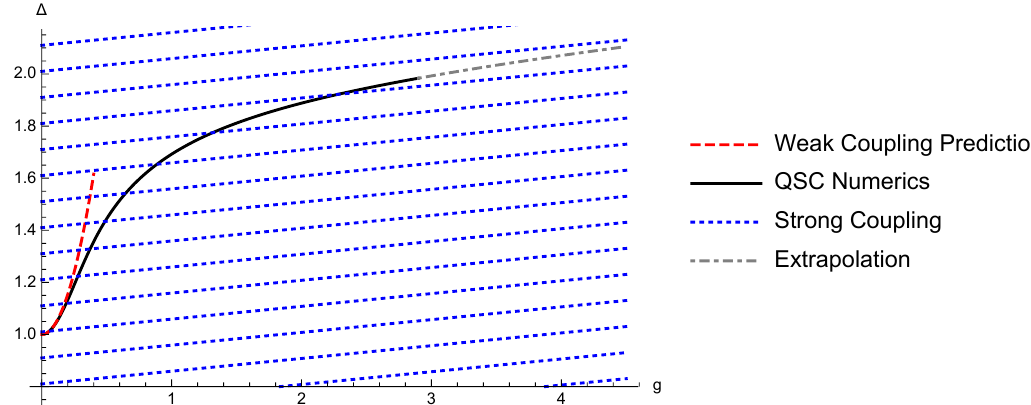
Figure 5 . This plot shows our numerical data for the case (cid:30) = 0 and (cid:18) = (cid:25)= 8. The dashed red line represents the one-loop result at weak coupling, which we conjecture to take the form (cid:1)( g ) = 1 + 4 g 2 cos 2 ( (cid:18)= 2) + O ( g 4 ), consistent with both the ladders limit and (cid:18) ! 0. The dotted blue lines represent the slope of the classical strong coupling result of [26]. The solid black line represents the numerical data obtained using the QSC. The dash-dotted grey line is found by extrapolating the obtained data to higher values of g